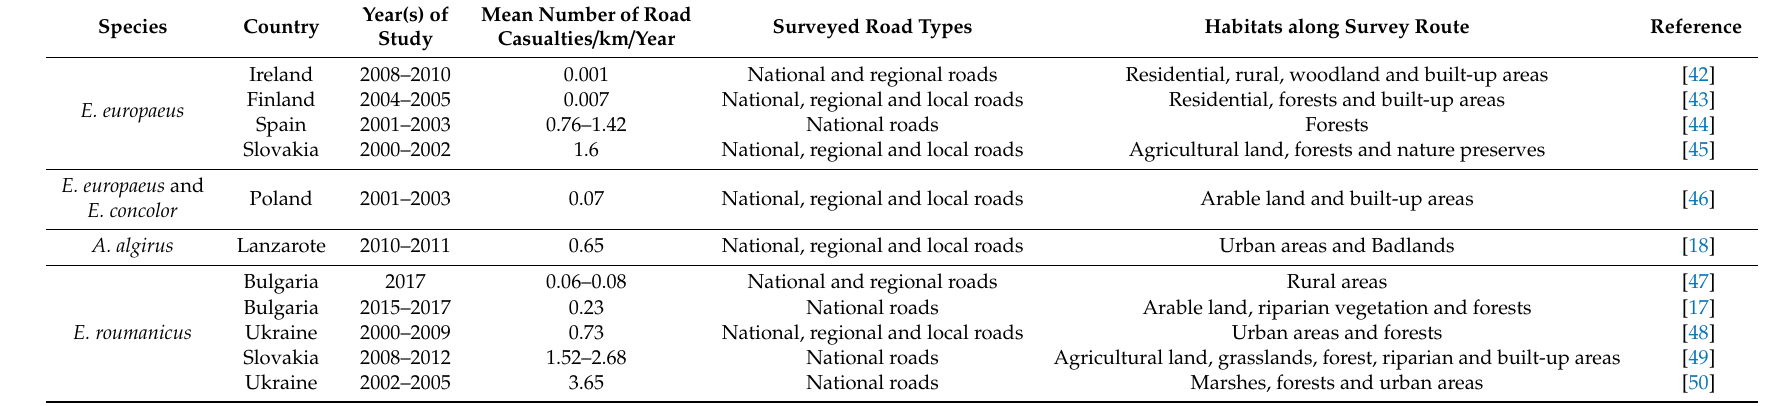
Table 1. Estimates of the mean number of hedgehogs killed on roads per kilometre per year in di ff erent European countries. Data are derived from systematic, year-round